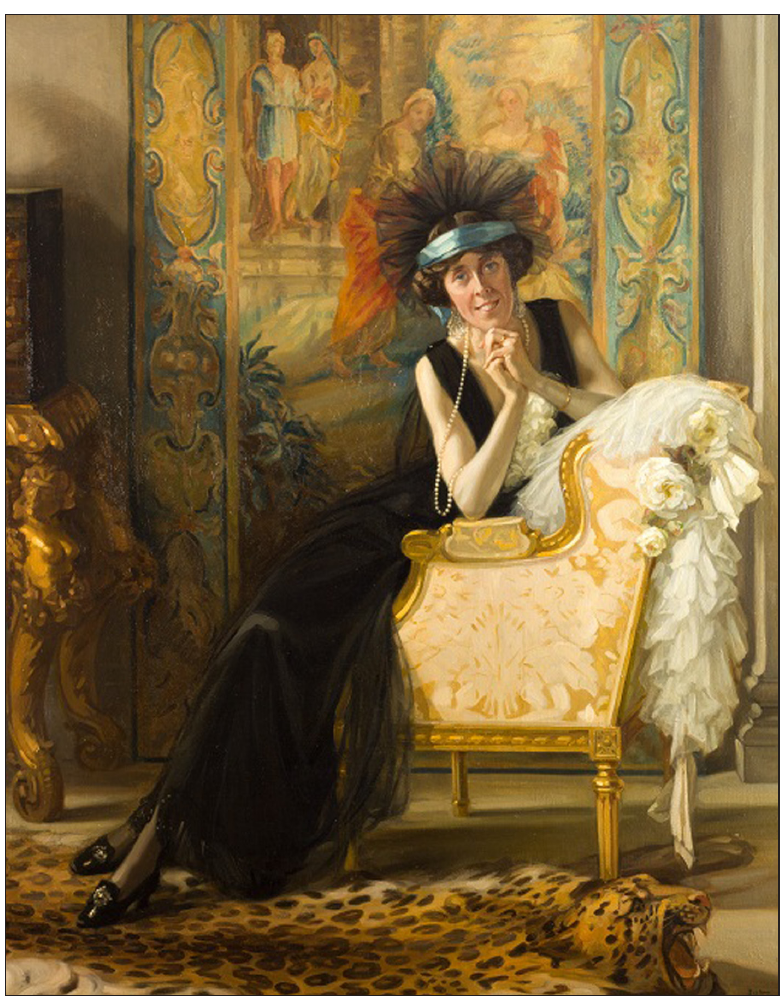
Fig. 1 : Nestor Cambier, Portrait of Lady Barber by a Leopard-Skin Rug , c. 1923, oil on canvas, 168 × 132 cm, Barber Institute of Fine Arts. © The Henry Barber